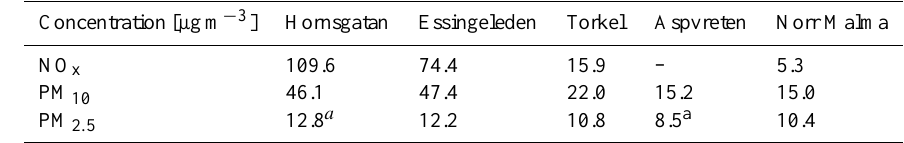
Table 3. Arithmetic mean NO x , PM 10 , PM 2 . 5 concentrations at the different sites for the period 20 April–5 July 2006. Concentration [µgm − 3 ] Hornsgatan